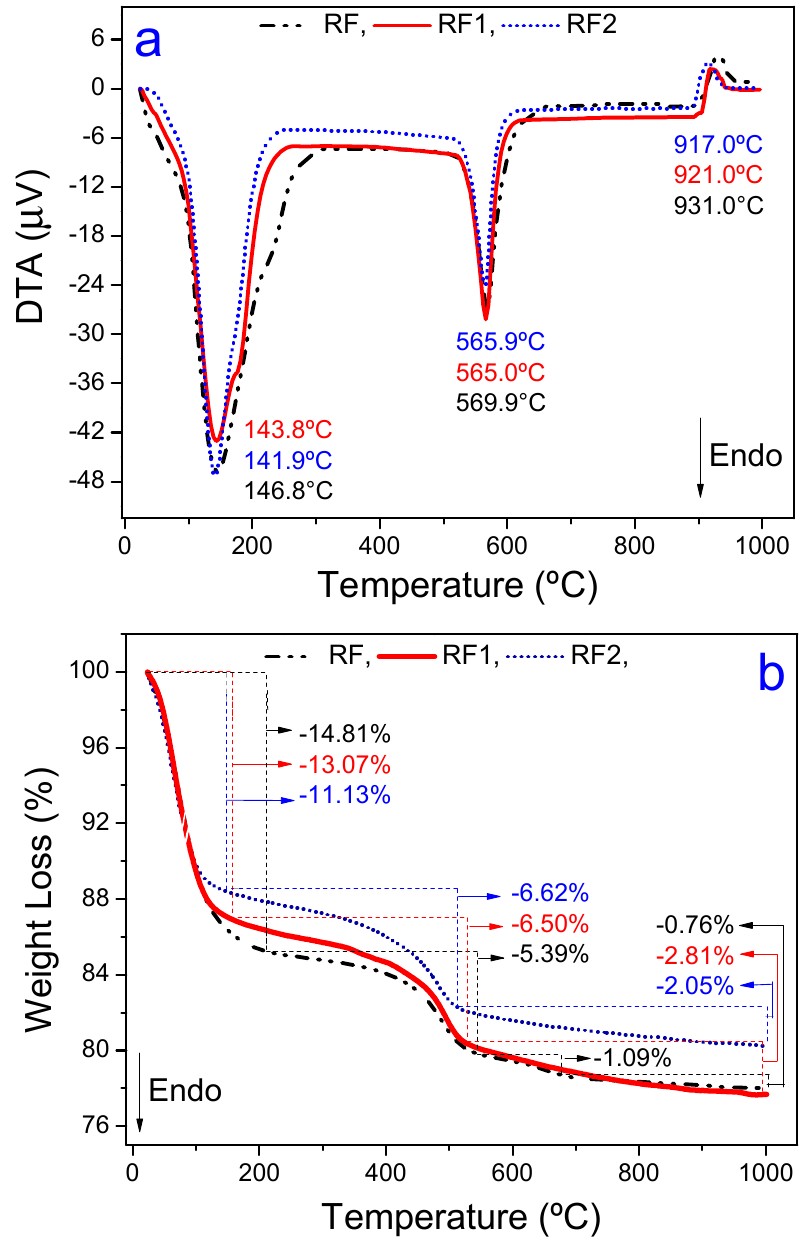
Figure 2. Shows DTA ( a ) and TG ( b ) curves measured from the RF, RF1, and RF2 clays.